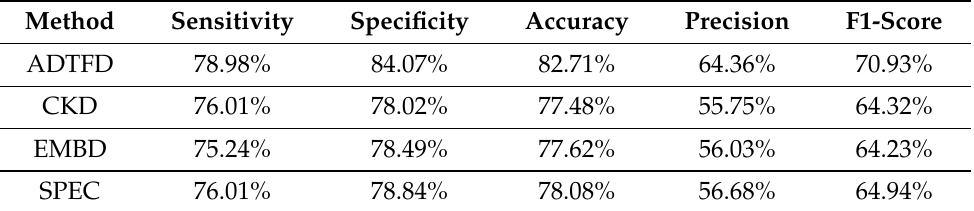
Table 3. Performance comparison using balanced dataset (i.e., equal examples of seizures and non-seizures).